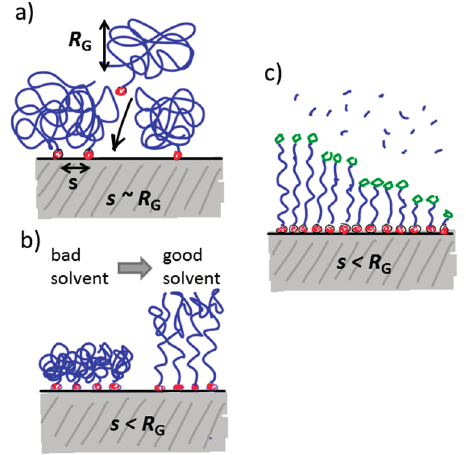
Figure 8. Schematic of “grafting to” and “grafting from” as standard techniques to create a sterically repulsive polymer coating at a sensor interface. ( a ) In grafting to a pre-synthesized anchor and spacer molecule is linked to the interface and the spacing between anchor groups ( s ) will at best on average be close to the radius of gyration of the polymer ( R G ). The polymer will be in mushroom configuration; ( b ) Grafting to can be performed in a poor solvent which reduces R G and allows for closer packing. Changing to a good solvent a polymer brush is created by swelling; ( c ) In grafting from an initiator is linked by an anchor to the surface. The polymer spacer is created by living polymerization from monomers in solution to create a dense